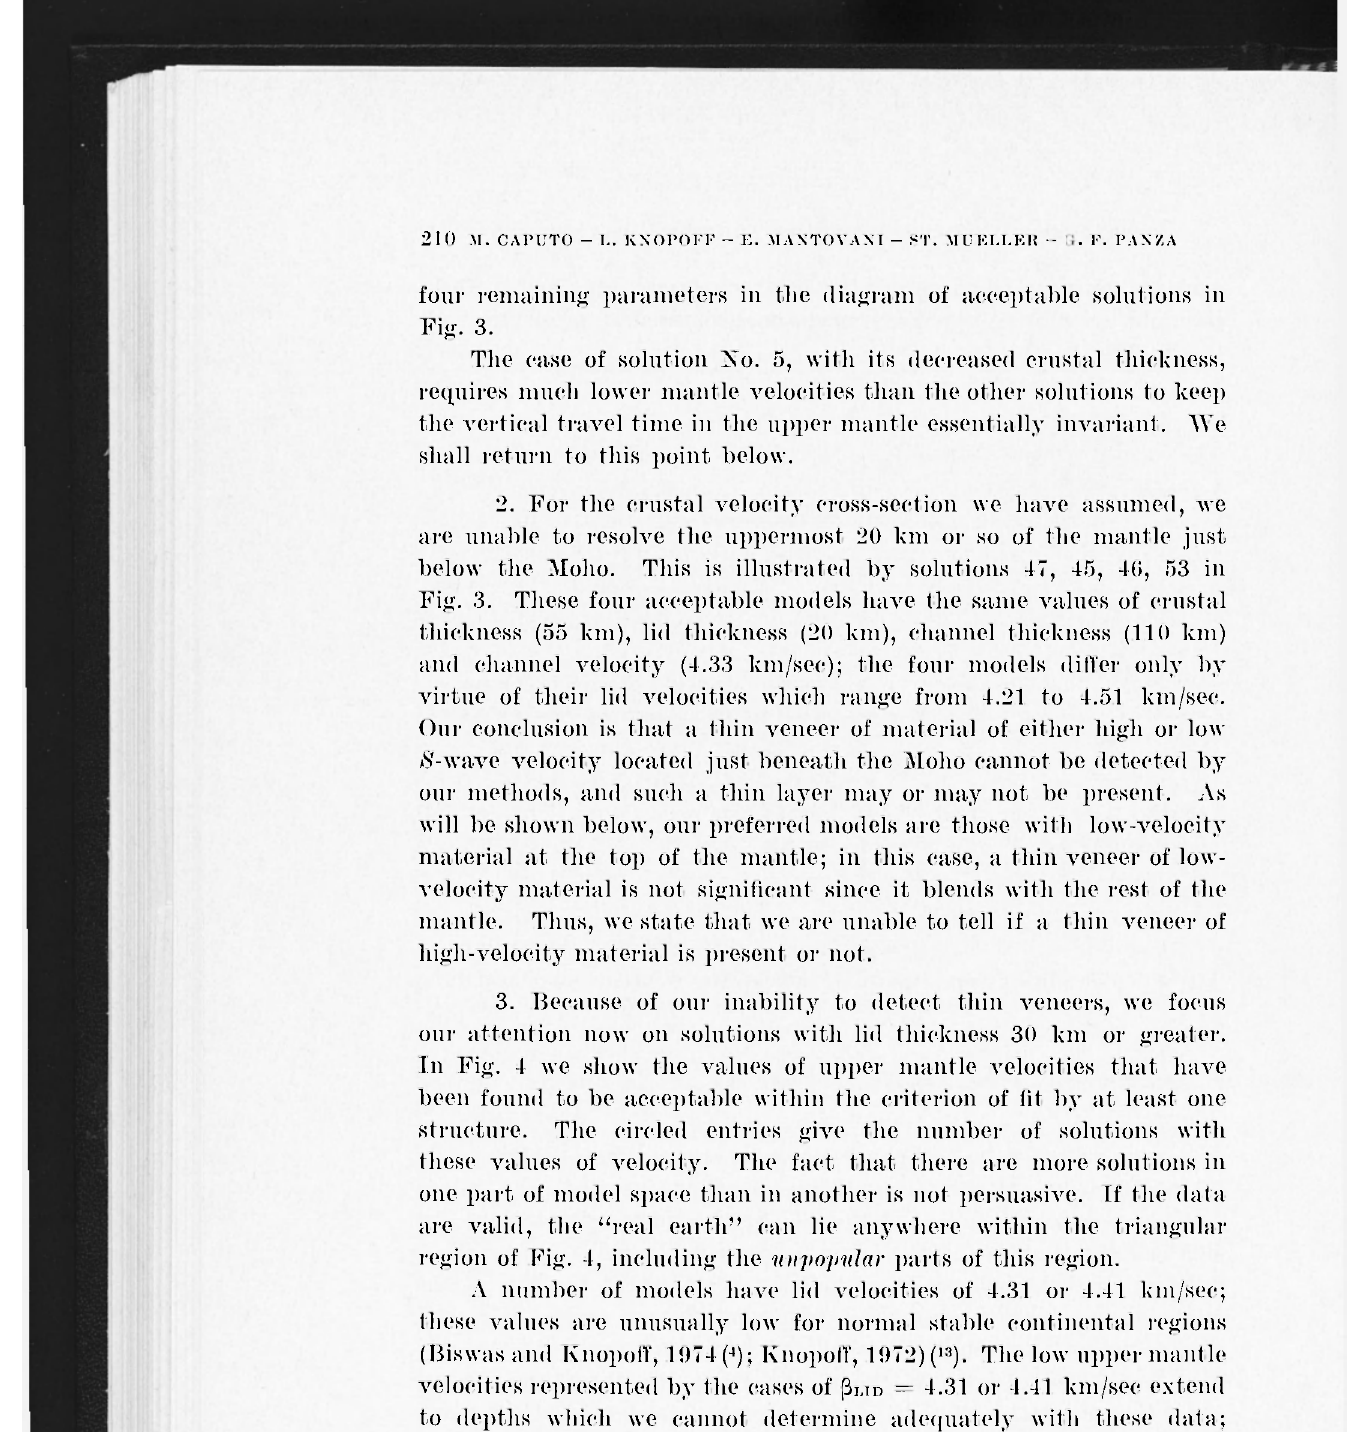
four remaining parameters in the diagram of acceptable solutions in Fig. 3. The case of solution No. 5, with its decreased crustal